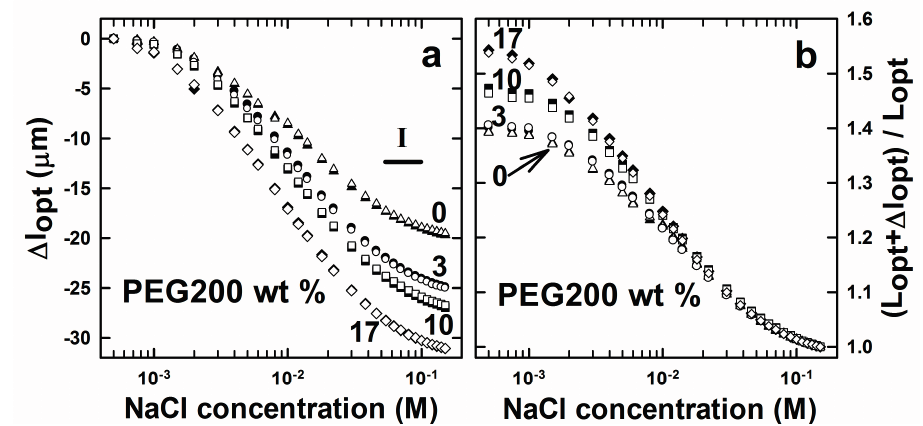
Figure 4. Changes in the optical length ( a ) and deswelling ratio ( b ) of AMPSA -co- AAm hydrogels consisting of 10 wt % AAm, 3 mol % Bis (relative to AAm) and 3 mol % AMPSA (relative to AAm) and with 0 (AMPSAGel0, l opt = 50.3 µm), 3 wt % (AMPSAGel3, l opt = 61.7 µm), 10 wt % (AMPSAGel10, l opt = 57.6 µm) and 17 wt % (AMPSAGel17, l opt = 57.2 µm) of PEG200 porogen removed right after synthesis. All measurements were carried out in NaCl concentrations ranging from 5 × 10 − 4 to 0.15 M and at least two times (open and filled symbols for each experimental series). Region I depicts the concentration range of NaCl selected for displaying the time dependence of Δ l opt (Figure